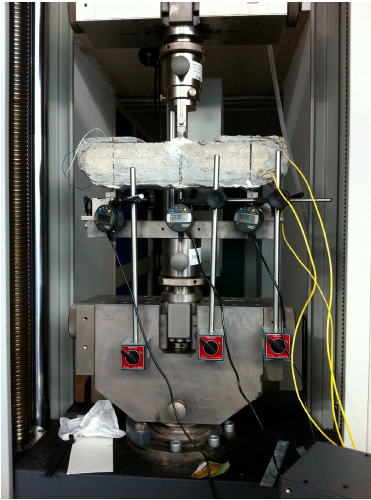
Figure 4. Three-point bending test carried out on FRCM strengthened beam instrumented with FBGs: Experimental set-up.